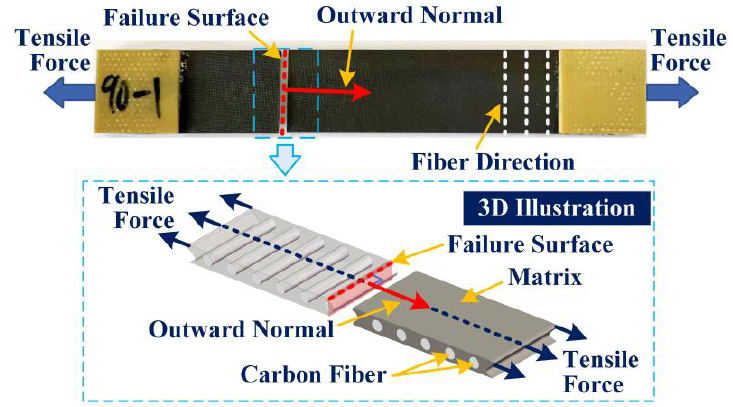
Figure 6. Comparison of predicted results with experimental results. Table 3. Transverse tensile strengths of the six UD composite specimens.